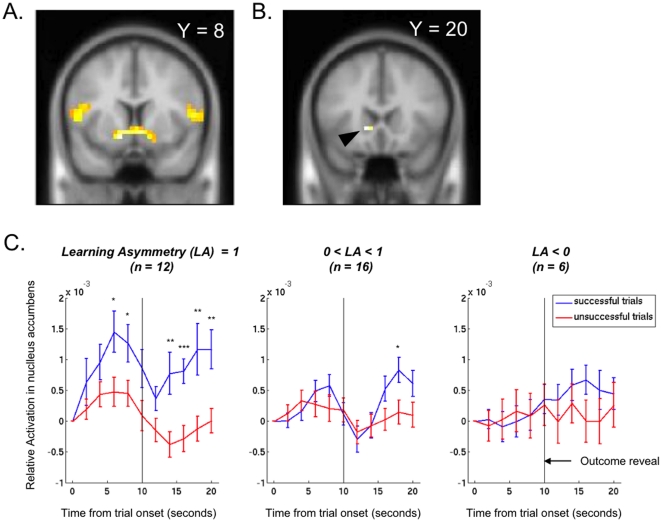
Ventral striatum correlates with prediction error at outcome in all subjects.Nucleus Accumbens correlates with learning asymmetry at trial onset. A: Activation from the analysis of correlates to prediction error across all subjects shown at p<0.001 uncorrected, Y = +8. B: Left nucleus accumbens correlates with learning asymmetry at trial onset, activation shown at p<0.001 uncorrected, Y = +20 (peak activation at (−14, 20, −2)). C: Timeseries of activation in left ventral striatum/nucleus accumbens separated by learning asymmetry and trial outcome: Success-chasers who completely ignore failure (left) show large anticipatory activation in the nucleus accumbens before both failures and successes, with even greater anticipation in advance of successes. They show even more significant differential activation to success vs. failure after the outcome reveal. People who over-weighted success but had positive learning rates on failures (middle) show some anticipatory activation in the nucleus accumbens before outcome reveal, but the area does not seem to significantly differentiate between successes and failures until after outcome is revealed. Finally, people who weighted failures more than success (right) show no anticipatory activation or significant differentiation between successes and failures after outcome is revealed. Significant differences in the timeseries are marked for p<0.05 (*), p<0.01 (**), and p<0.001 (***) in a 2 sample t-test. Note that timeseries are time-locked to scenario presentation time.